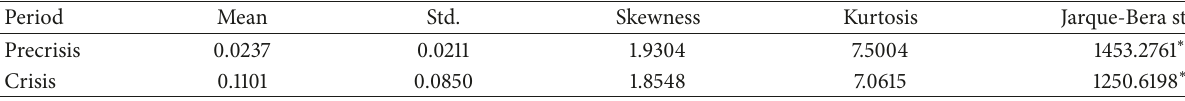
Table 2: Descriptive statistics of the MI values for the 32 stock indices.